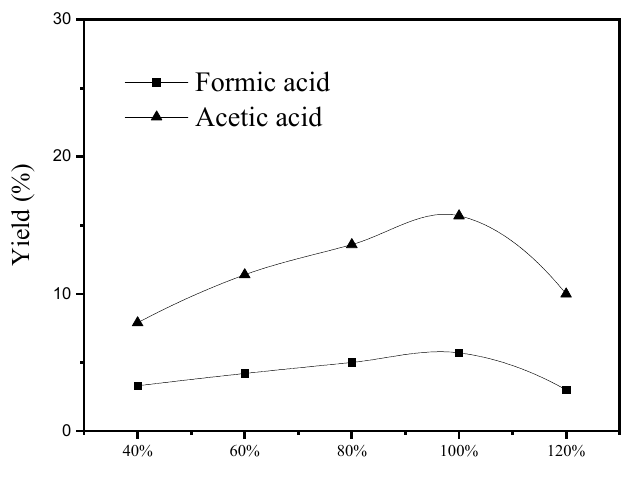
Figure 4. Effects of reaction time.